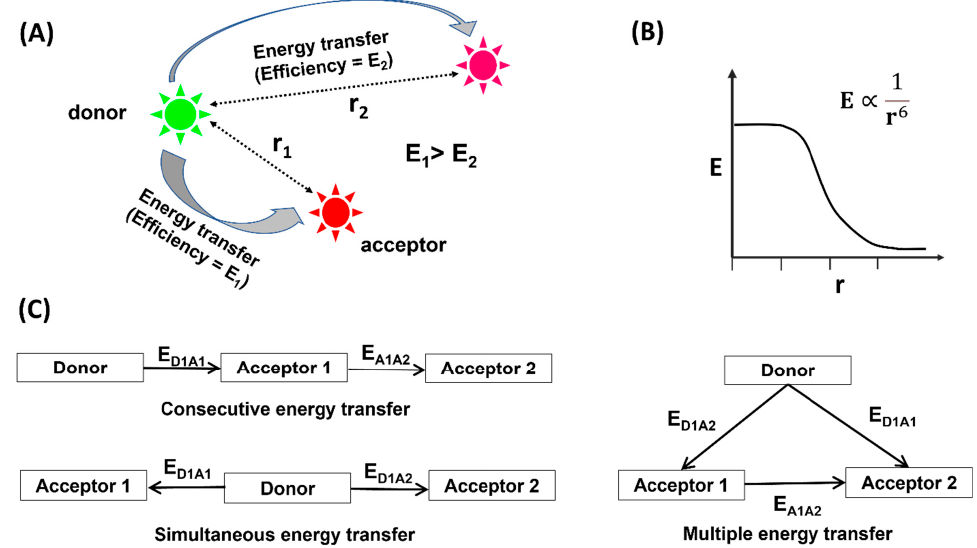
Figure 1. Schematic of FRET. ( A ) The energy is transferred from a donor fluorophore (green) to acceptor fluorophore (red/pink) in a distance-dependent fashion. ( B ) The change in efficiency of energy transfer (E) with the distance between the fluorophores. ( C ) Different cases of energy transfer for more than two fluorophores. Chromatins are the structural constituents of eukaryotic chromosomes and have a “beads on a string” structure [33]. The “beads” therein are scientifically termed nucleo- somes and are composed of DNA and histone proteins, whereas the string is the linker DNA (Figure 2). Chromatins are widely studied owing to the fact that chromatin struc- tures and dynamics are central to understanding the process of gene regulation. Although